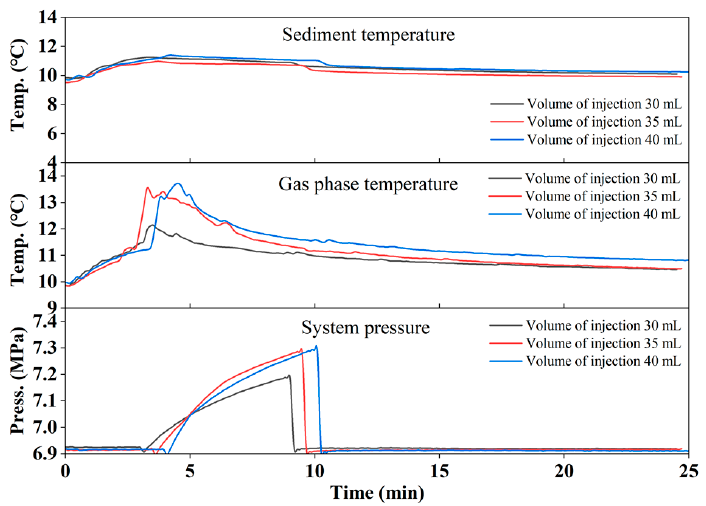
Figure 3. Temperature and pressure changes under different volumes of injected hot water in the sediments at 9 °C and 6.9 MPa with 30% hydrate saturation.